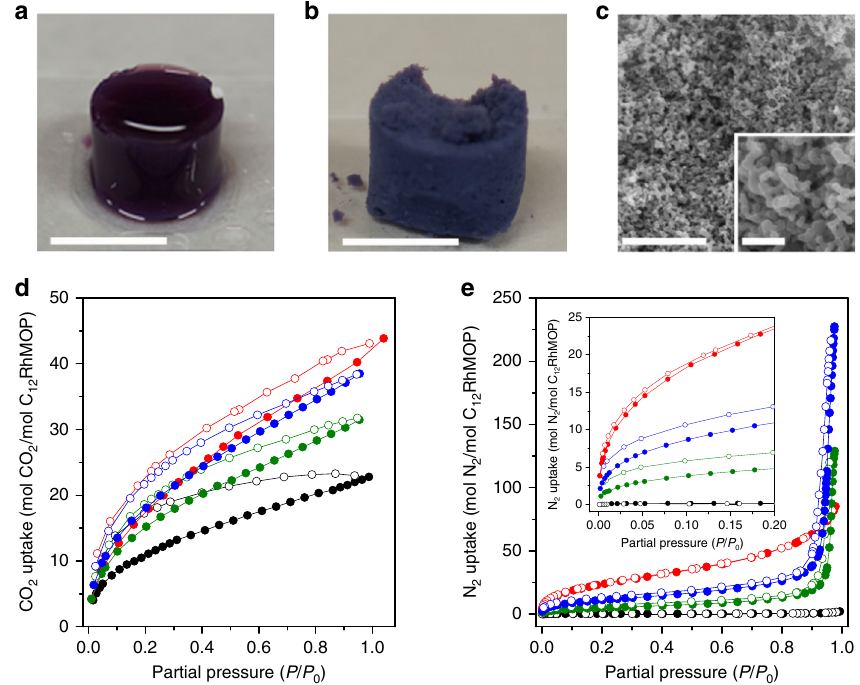
Fig. 5 Drying of supramolecular colloidal gel leading to a supramolecular aerogel, and effect on gas sorption properties of the macroscopic structures of the polymers. a Photographs of a standalone SCG-1 ( a ) and b , the corresponding SAG-1; scale bars: 1 cm. c Representative FESEM image of SAG-1 and a magni fi ed view of the material; scale bars: 1 µ m, and (inset) 200 nm. d CO 2 adsorption isotherm at 195 K and e N 2 adsorption isotherm at 77 K of SAG-1 (red), CPP-1_small (blue), CPP-1_big (green), and C 12 RhMOP (black). The inset highlights the adsorption at low pressure. Filled and empty symbols correspond to adsorption and desorption,